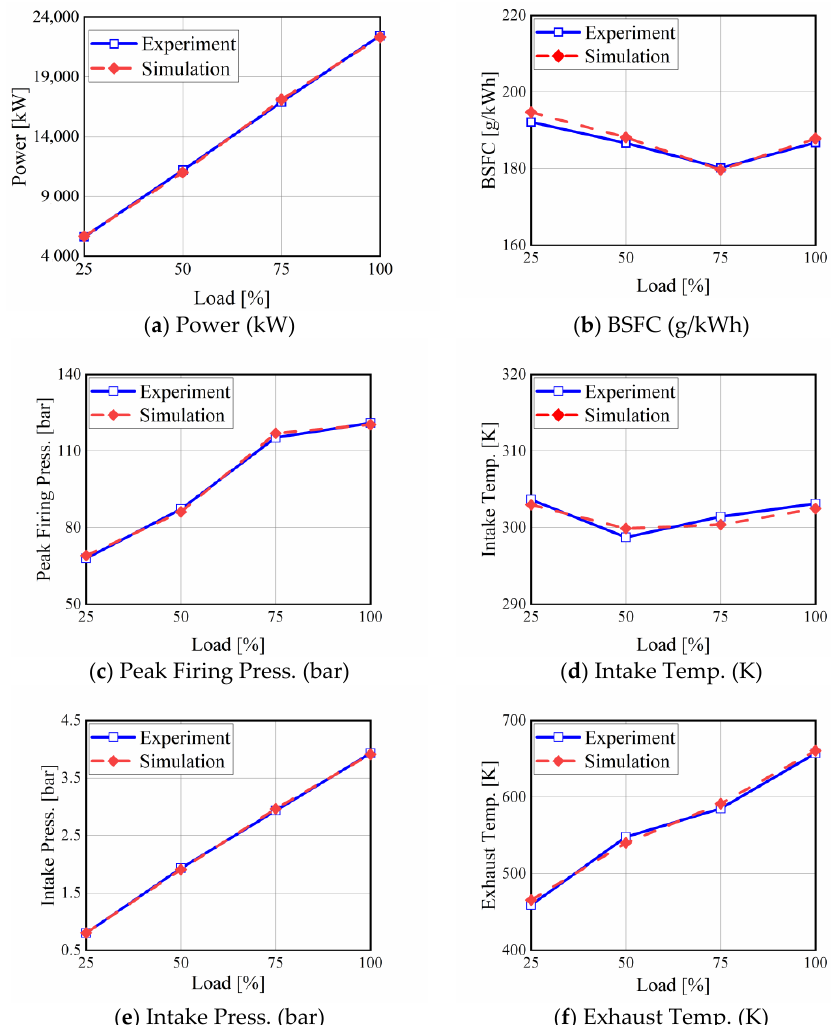
Figure 3. Comparison of the simulation and experiment in diesel mode. Table 3. Calculation errors of the parameters in diesel mode.